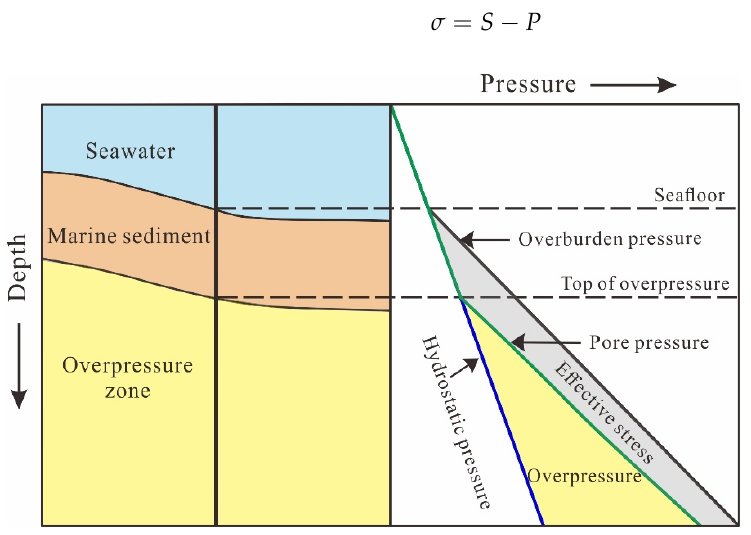
Figure 1. Pressure–depth profile in marine sediments (modified from Dutta [8]).